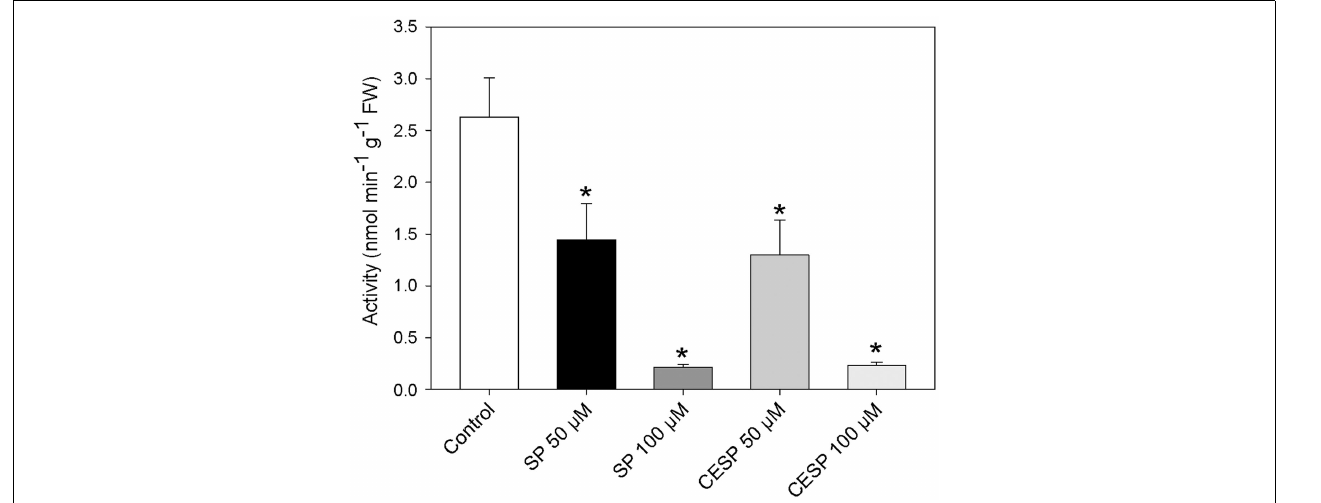
FIGUREA2 | MapMan visualization of differences in transcript levels between control samples and SP-treated samples.